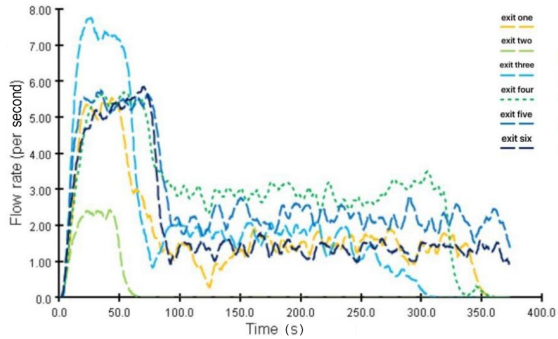
Fig. 7 Evacuees’ pass rate in each